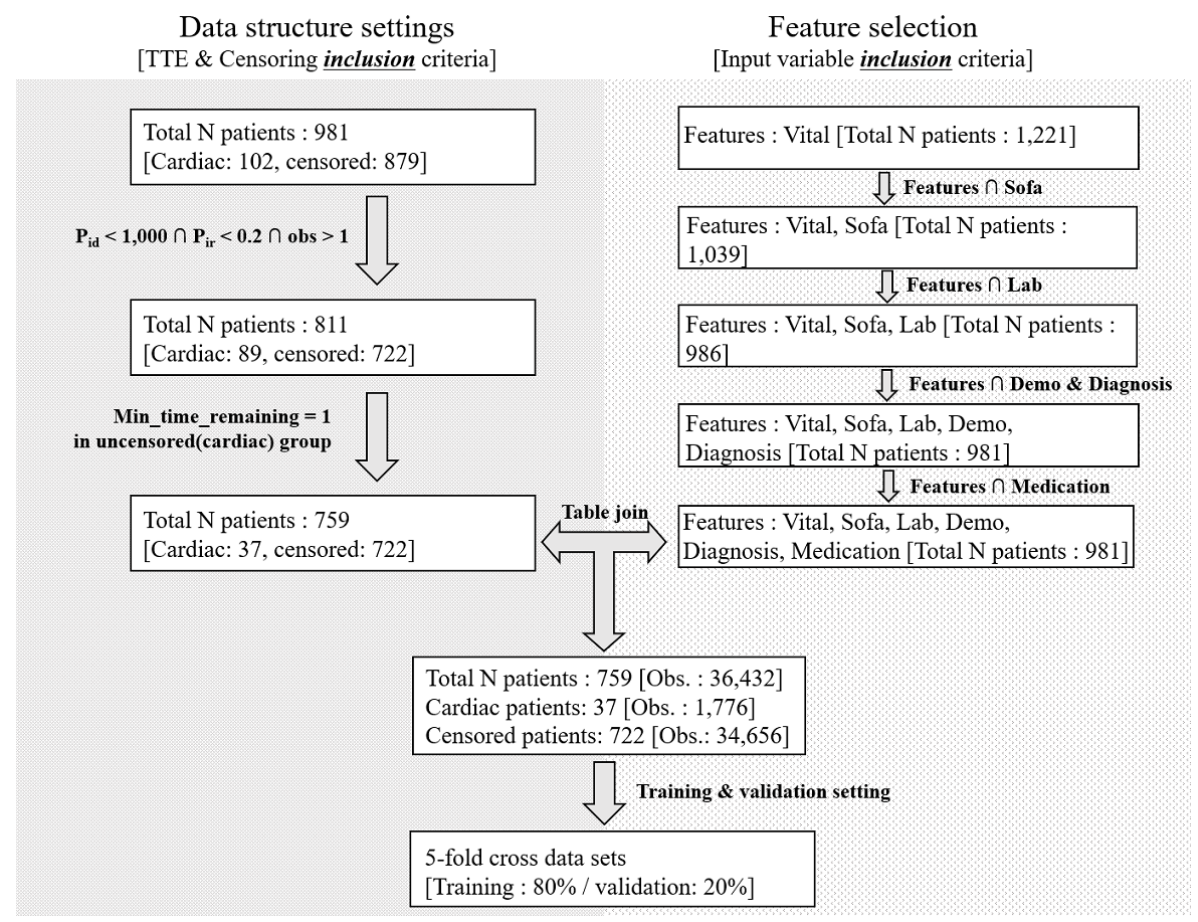
Figure 1. Data preprocessing flowchart. Obs: observation; TTE: time to event.